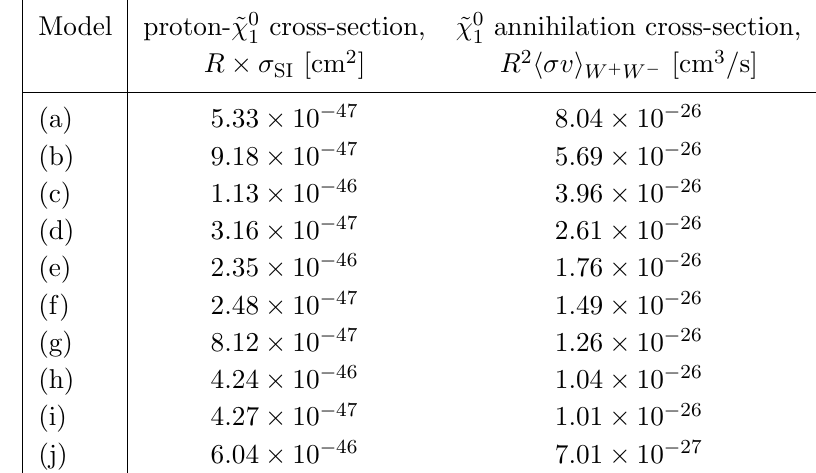
Table 3. The spin-independent proton-neutralino scattering cross-section, R (cid:2) (cid:27) SI (second column) and the thermally averaged neutralino annihilation cross-section, R 2 h (cid:27)v i channel (third column) for the ten benchmarks of table 1. Here R (cid:24) 1 due to the hidden sector